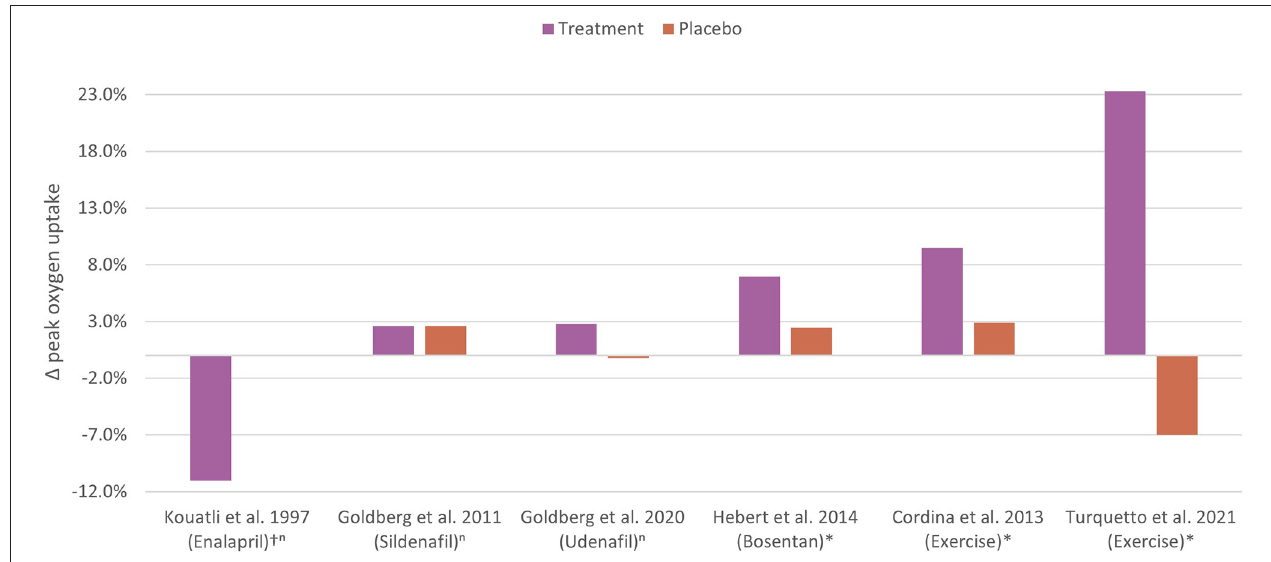
FIGURE 5 | Controlled trials of non-invasive therapy to improve aerobic exercise capacity in the Fontan circulation. The percentage change in peak oxygen uptake following non-invasive therapies or placebo in Fontan cohorts are shown. The most effective non-invasive therapy is exercise training. n, non-significant; *, statistically significant; † , percentage difference between groups. Kouatli et al. (120); Goldberg et al. (63); Goldberg et al. (62); Hebert et al. (64); Cordina et al. [high intensity resistance training] (108); Turquetto et al. [combined aerobic exercise and light resistance training]